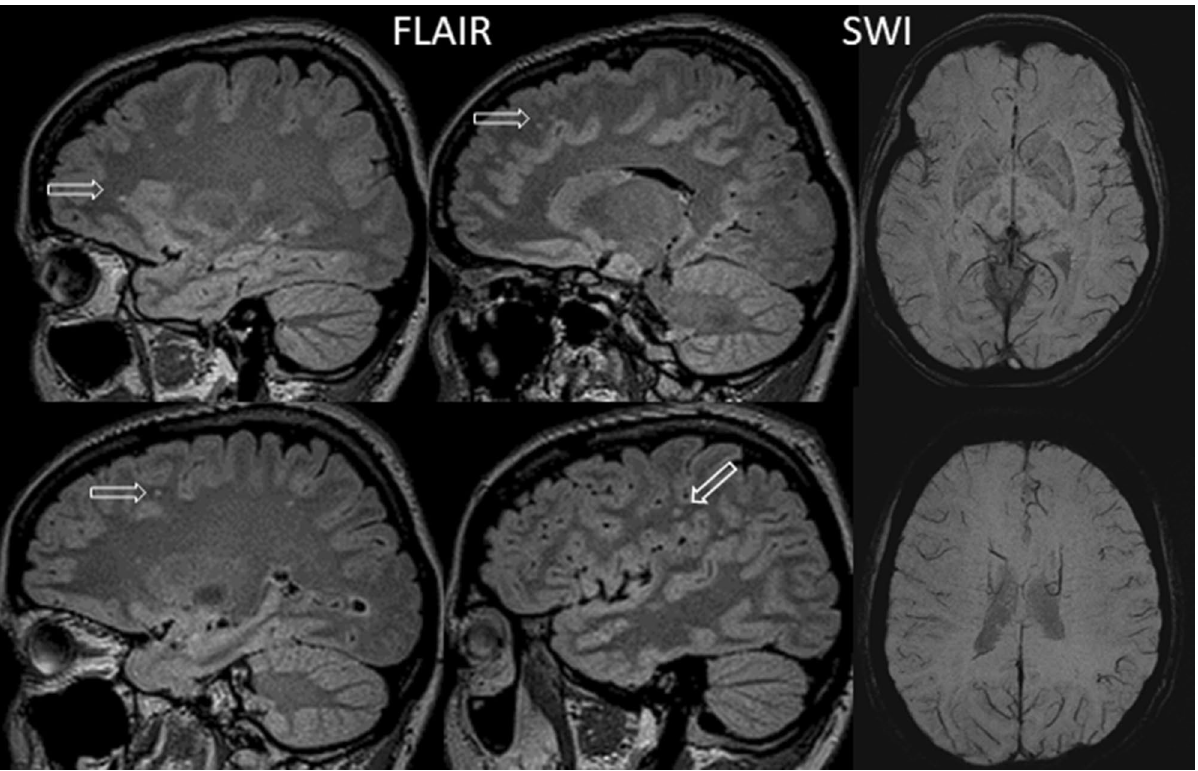
Figure 2. 33-year-old female patient, presented with migraine with aura for 10-year duration. Sagittal FLAIR MRI image shows punctate hyperintensities in the white matter within the frontal and parietal lobes (1–2 mm). There are no microbleeds on SWI